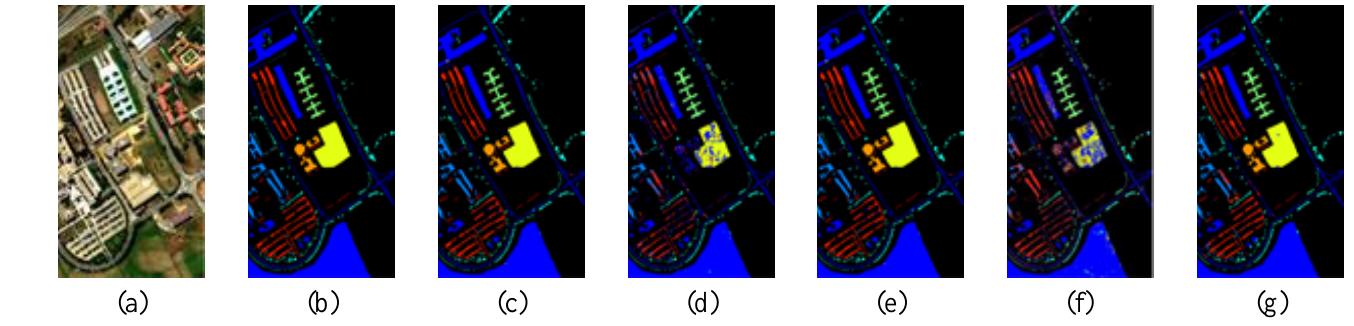
Figure 8. ( a ) False-color composite (R: 53, G: 31, B: 8), ( b ) Ground truth, ( c ) SS-3DCNN